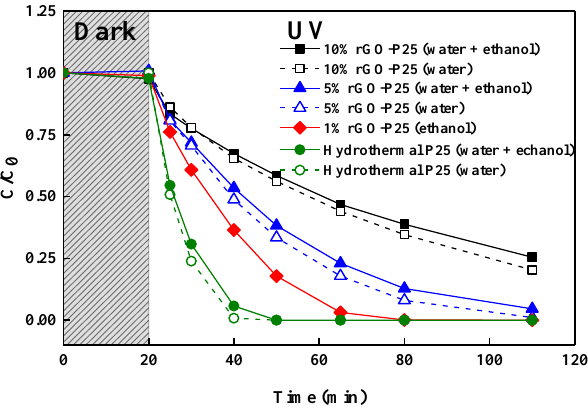
Figure 3. E ff ect of solvents and contents of rGO on bisphenol A (BPA) degradation by rGO–P25 Figure 3. Effect of solvents and contents of rGO on bisphenol A (BPA) degradation by rGO – P25 under under UV-light irradiation (BPA concentration = 0.01 mol / L, catalyst dosage = 0.5 g / L, volume of the UV-light irradiation (BPA concentration = 0.01 mol/L, catalyst dosage = 0.5 g/L, volume of the solution solution = 100 mL, λ = 350 nm, ten tubes). = 100 mL, λ = 350 nm, ten tubes).